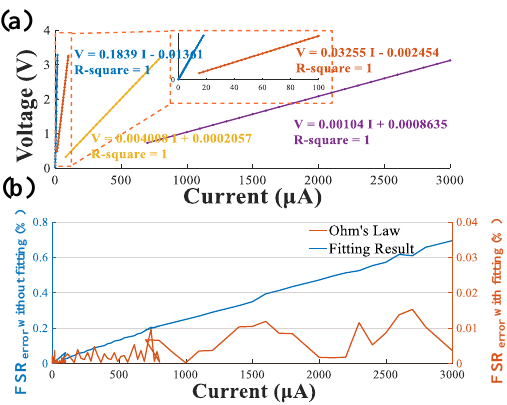
Figure 3. Validation of the micro galvanometer. ( a ) The linear correlation between the standard current and the output voltage measured by micro galvanometer; ( b ) the measured full-scale error (%FSR error ).